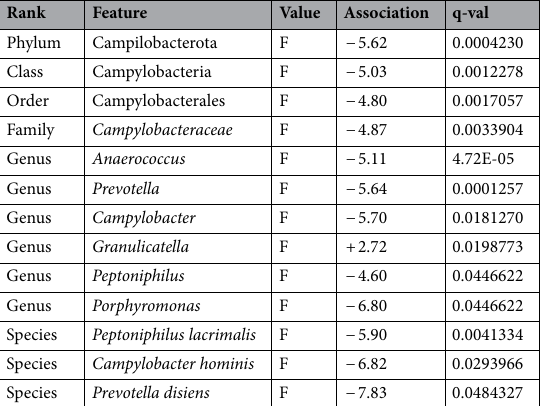
Table 1. The taxa obtaining a relevant association to sampling matrix are listed. For each taxa the taxonomic rank (rank), the scientific name (feature), the reference value for association (value), the association (Association) and the obtained adjusted p-value (q-val) are